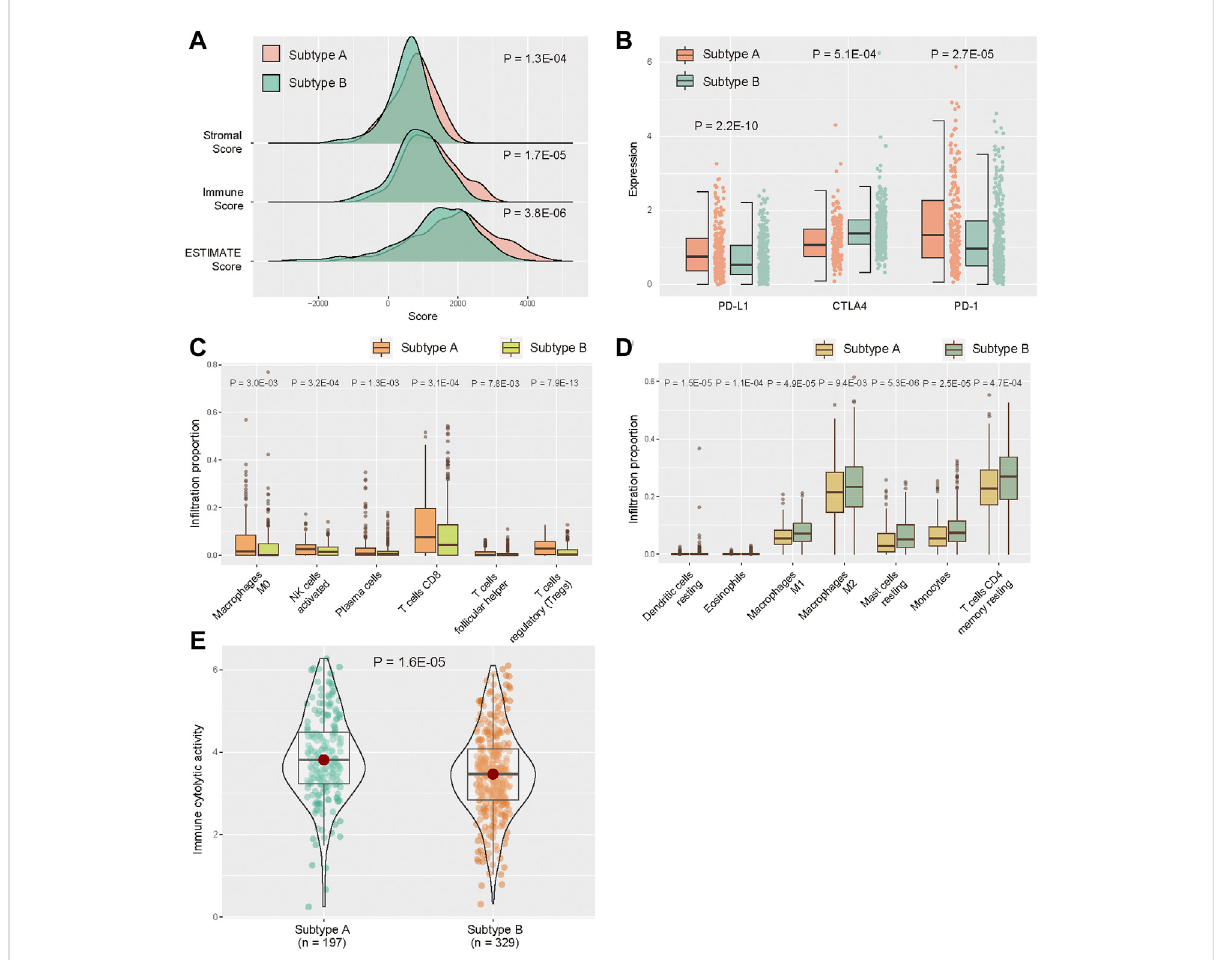
FIGURE 3 Distribution of TMEbetween subtype A and subtype B. (A) Distribution of ESTIMATE score in two subtypes. (B) Expression levels of fi ve immune checkpoints betweentwo subtypes. (C,D) Abundance of in fi ltrating immune cell types betweentwo subtypes. (E) Distribution ofimmuneCYTscore between two